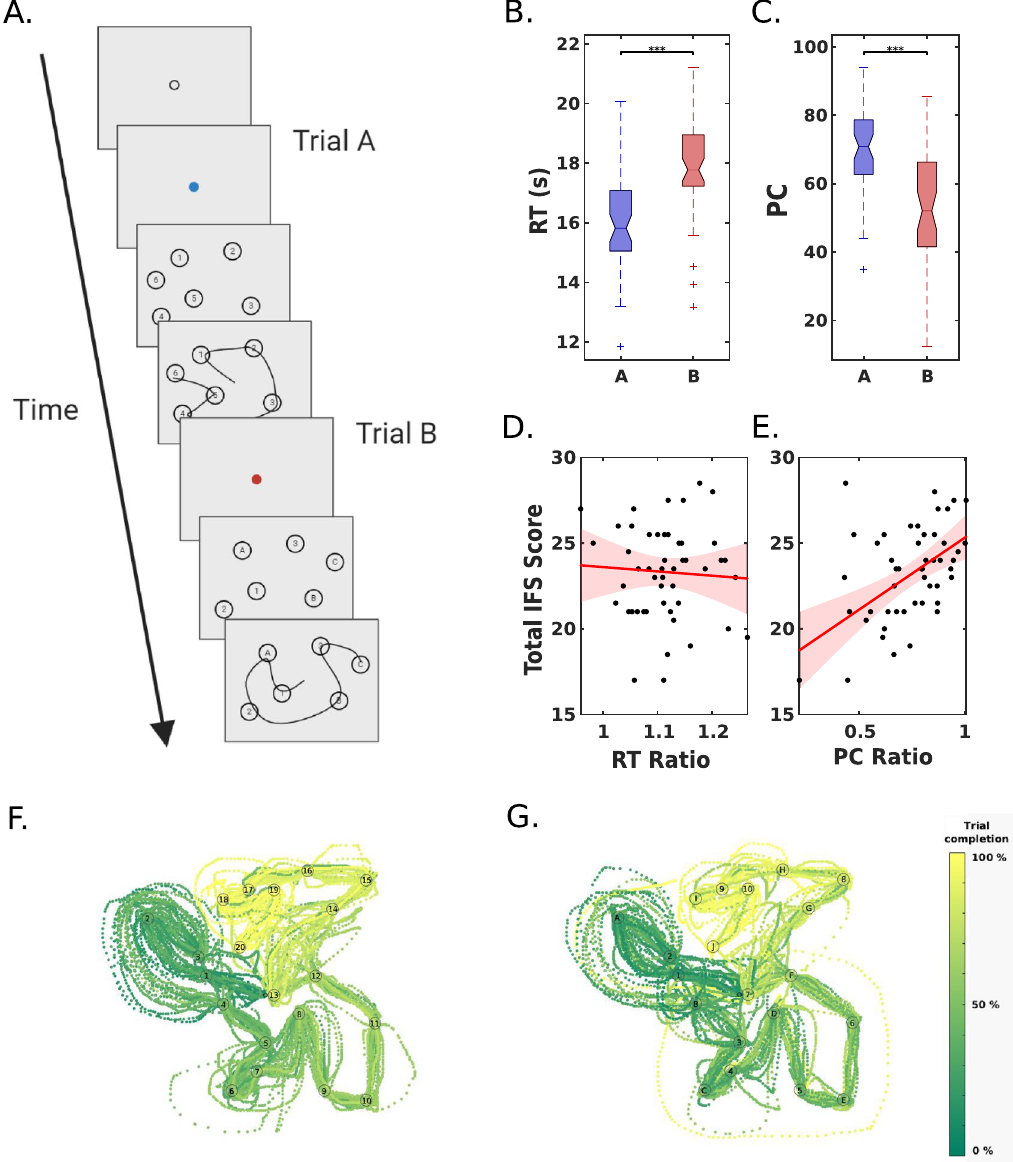
Figure 1. ( A ) Experimental design and task validation. The trial begins with a mouse button press and continues until the mouse button is released or a maximum time of 25 s is reached. ( B ) Time to connect 12 items in order (completion criteria), and ( C ) Percentage of completed trials (PC) for both Part-A and Part-B. ( D ) Correlation between the Total IFS Score and the Completion Ratio (PC-B/PC-A). ( E ) Correlation between the Total IFS Score and the RT Ratio (RT-B/RT-A) ( F ) Hand trajectory in an A type trial. ( G ) Hand trajectory in a B type trial, with the same configuration. The colour bar represents the relative temporal evolution for